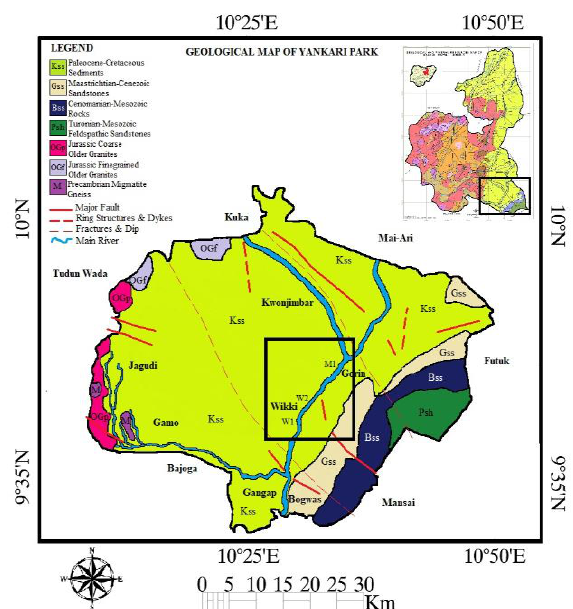
Figure 1. Geological Map of Yankari Park Showing the Study Area